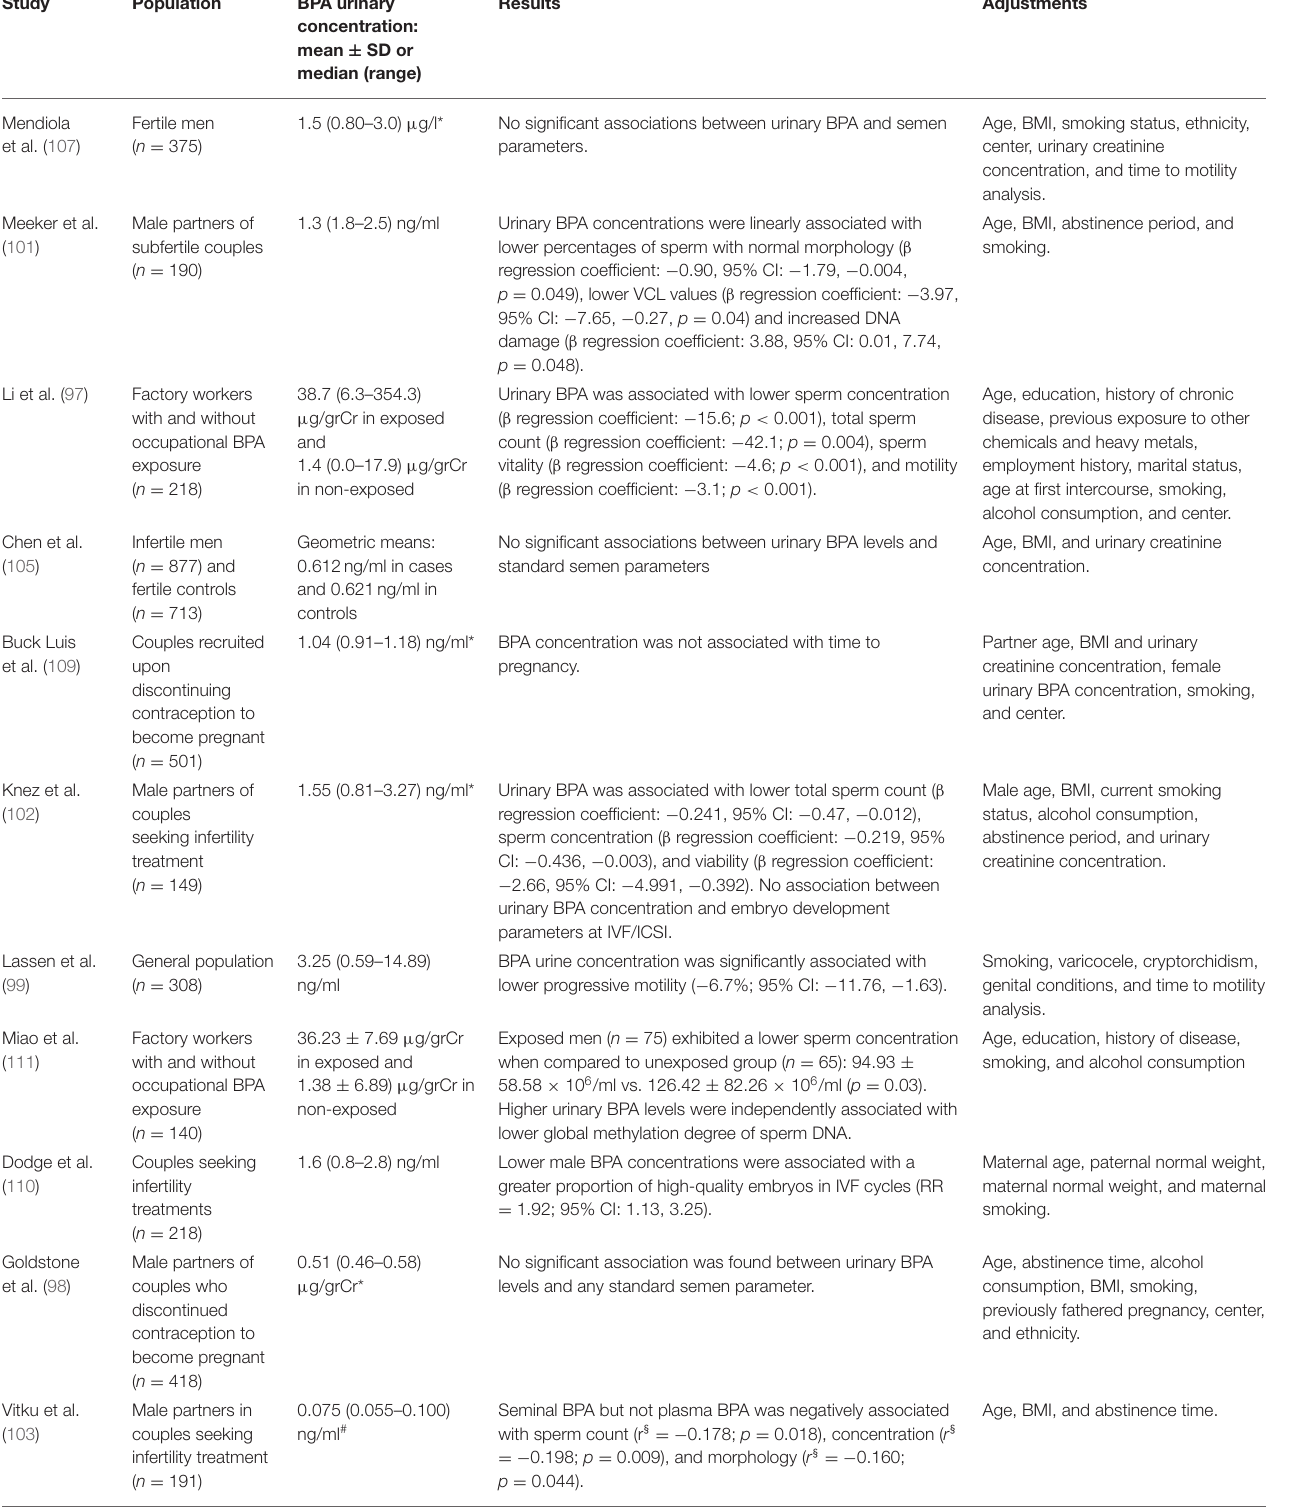
TABLE 1 | Epidemiological studies on the relationship of urinary BPA concentration with semen quality and/or other reproductive outcomes. Study Results